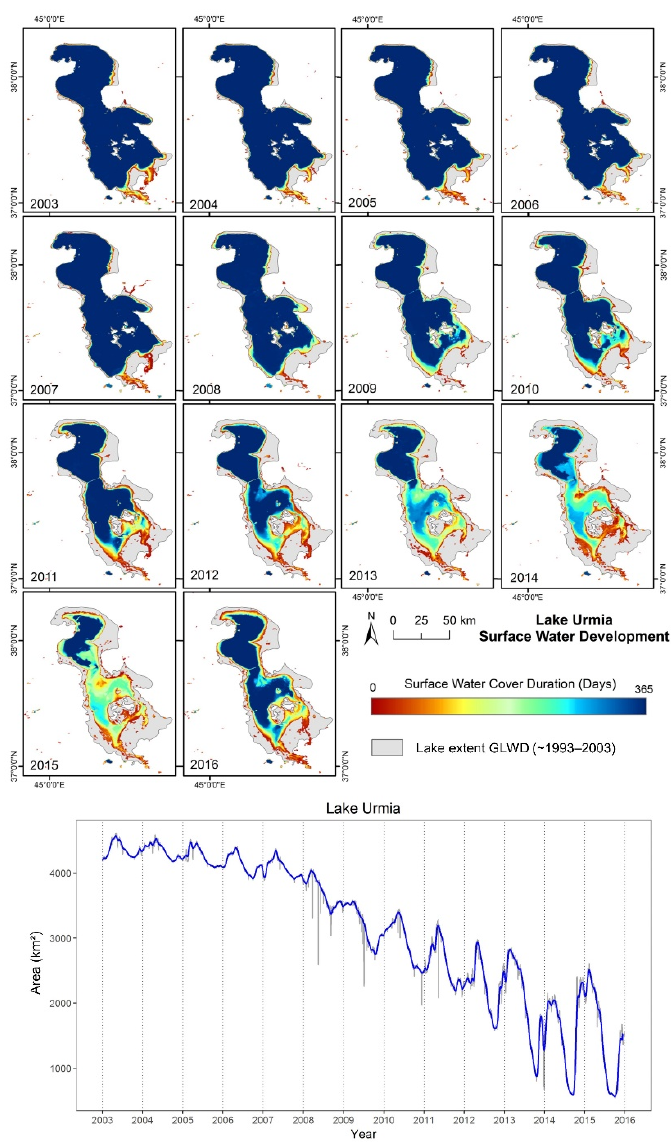
Figure 1. Global WaterPack (GWP) application to monitor the surface water decline of Lake Urmia from 2003–2016. Grey areas refer to the Global Lakes and Wetlands Database (GLWD) [34]. For the GWP time series generation, primarily, the 250 m RED (620–670 nm) and NIR (841–876 nm) channels of MODIS sensors Aqua (MYD09GQ) and Terra (MOD09GQ) are utilized in a dynamic threshold-based classification [9]. Additionally, several auxiliary layers (multispectral information, day–night difference, urban areas, relief shadows, ther- mal information) are used to refine classification output and mask clouds (MODIS MYD10A1 and MOD10A1). Data gaps in the original product (mostly due to cloud cover) are interpolated using a moving window approach [9]. For this study, we utilize the com- plete global coverage of the GWP product for all currently available years (2003–2020). Furthermore, artificially gapped time series of ten years duration (2010–2019) are gener- ated for a selection of four ROIs (MODIS tiles h10v08, h17v07, h18v03 and h24v05), to evaluate temporal probability layers in detail (Figure 2).